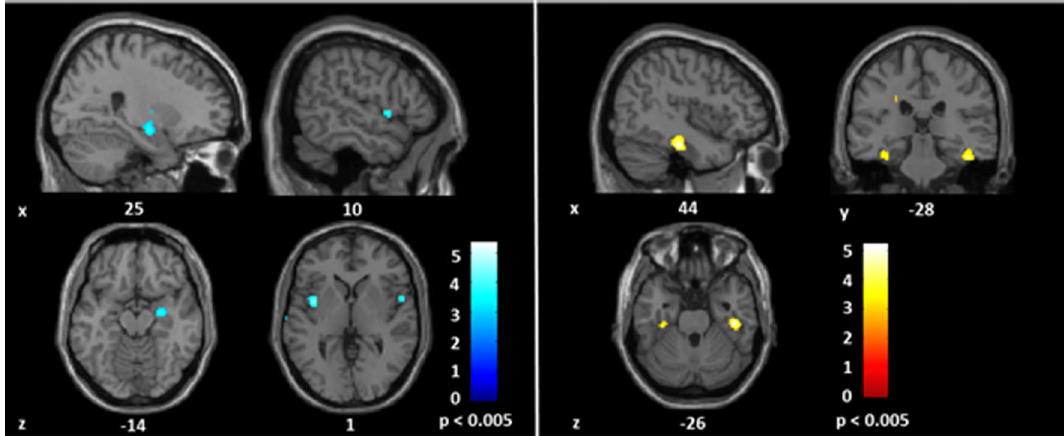
Figure 5. Regional cerebral glucose metabolism (rCGM) during navigation compared to locomotion in healthy controls and BVP patients. A direct comparison between groups for the navigation versus locomotion condition revealed a significant decrease of rCGM in the right hippocampal formation and bilateral insular cortex, and a significant increase of rCGM in the bilateral parahippocampus and lingual gyrus (i.e., parahippocampal place are, PPA) in BVP patients compared to healthy controls. Significance level: p < 0.005; colour scale indicates t-score; levels of sections in x- and z-direction are given by MNI coordinates. BVP: bilateral vestibulopathy.